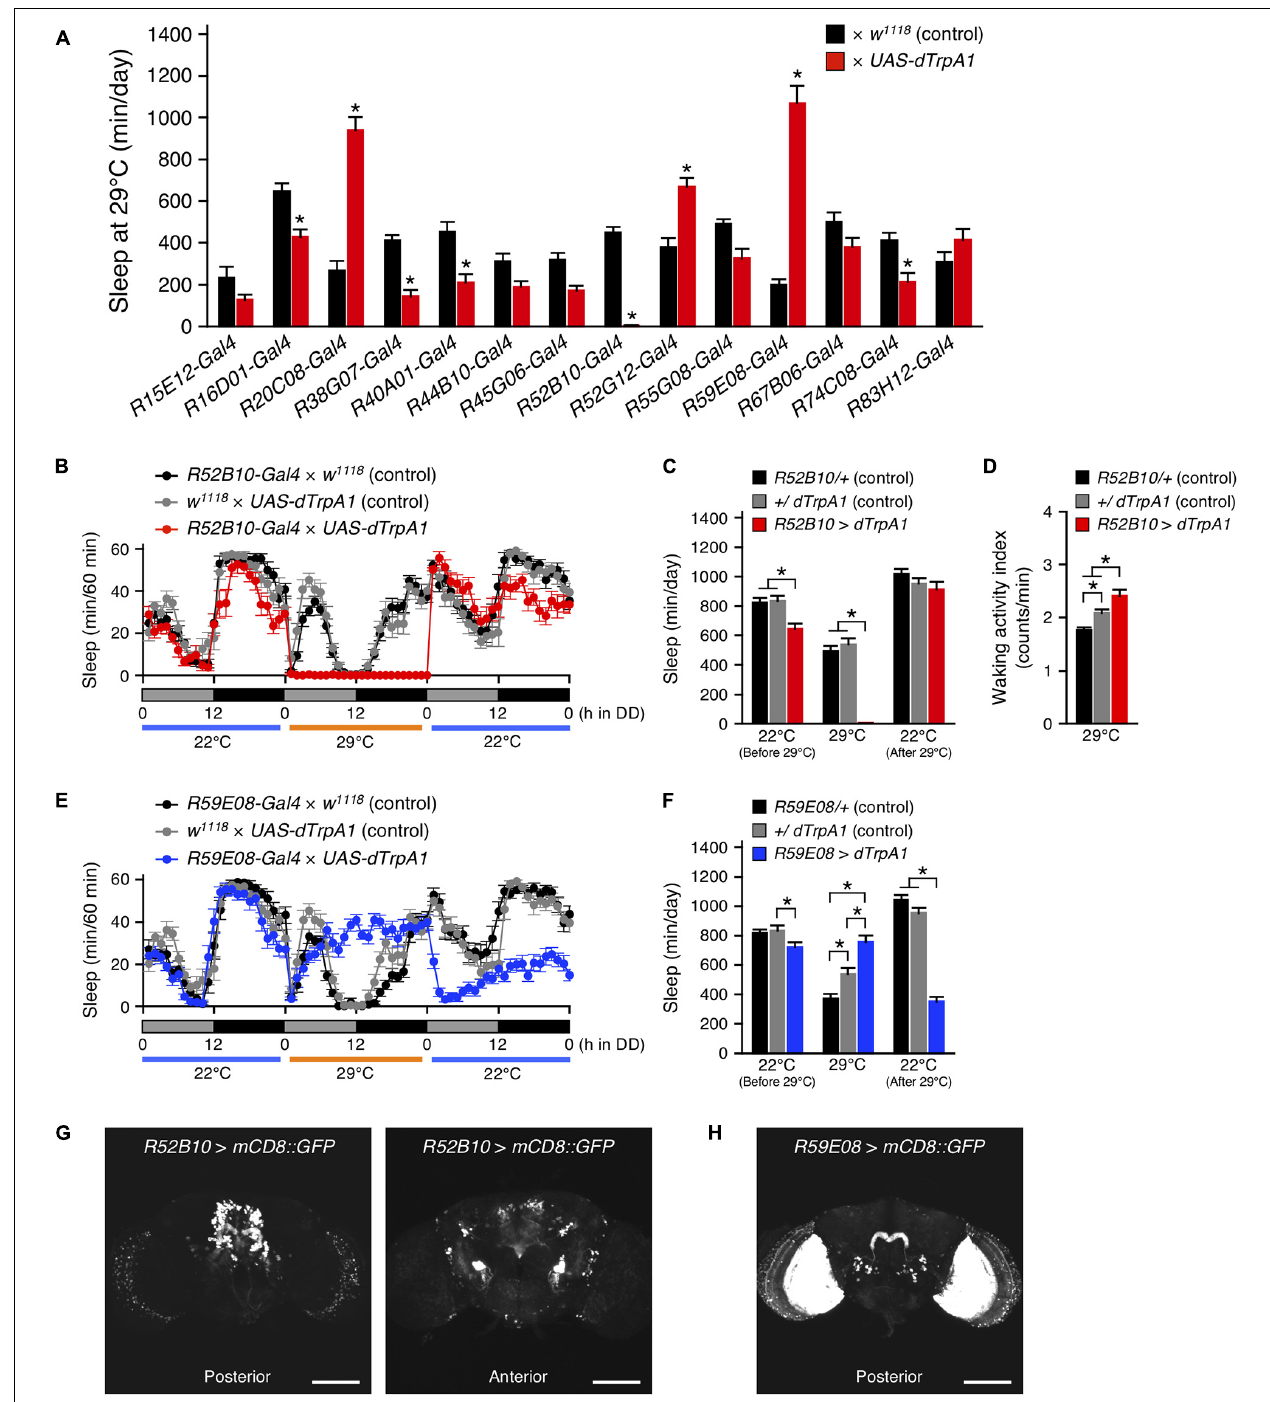
FIGURE 2 | Acute activation of the PB neurons affected sleep. (A) The amount of sleep per day at 29 ◦ C in DD conditions in control flies (black bars) and flies expressing dTrpA1 transgene by indicated Gal4 drivers that highly express in PB neurons (red bars). For controls, each Gal4 driver was crossed with w 1118 (the genetic background of UAS-dTrpA1 carrying flies). Data are presented as mean ± SEM ( n = 6–16 for each group). Asterisks indicate statistically significant differences from control determined by one-way ANOVA followed by Tukey-Kramer post hoc test ( p < 0.05). (B–D) Sleep profiles for 60-min intervals (B) , total daily sleep (C) or waking activity index (D) for controls ( R52B10-Gal4 × w 1118 , black circles or bars, n = 16; w 1118 × UAS-dTrpA1 , gray circles or bars, n = 16) or flies expressing dTrpA1 with R52B10-Gal4 ( R52B10-Gal4 × UAS-dTrpA1 , red circles or bars, n = 16) in DD. Behavior was monitored in DD for 1 day at 22 ◦ C, followed by 1 day at 29 ◦ C (dTrpA1 activation), and 1 day at 22 ◦ C. Gray and black bars under the horizontal axis indicate subjective day and night, respectively. Data are